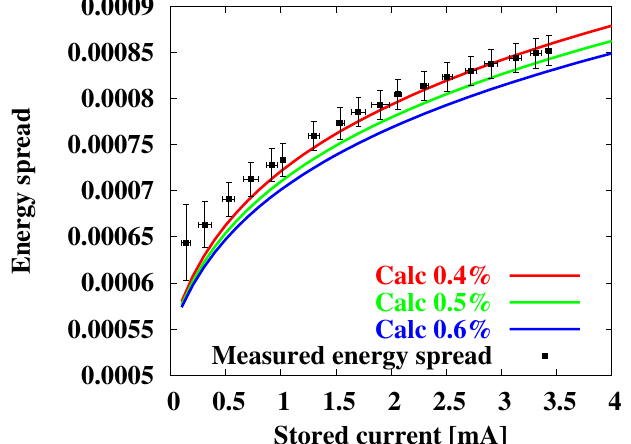
FIG. 18. (Color) Measured energy spread at the extraction line vs beam current in the single-bunch mode. The lines are from a calculation with intrabeam scattering, assuming coupling ratios of 0 : 4% , 0 : 5% , and 0 : 6% .